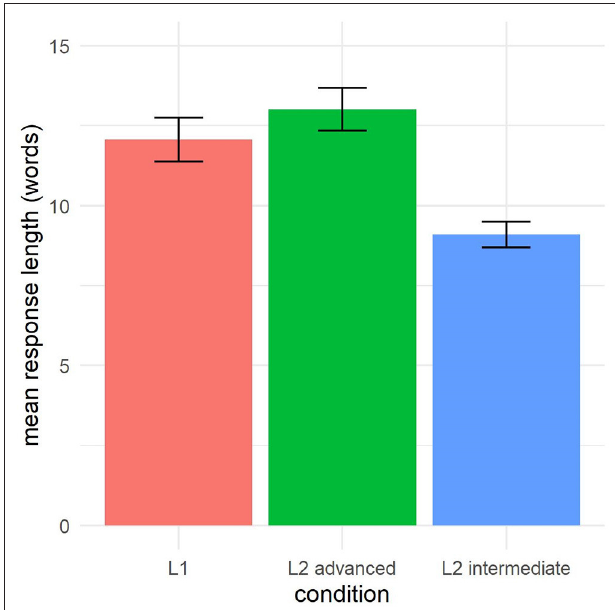
FIGURE 4 | Response length as mediated by condition (error bars: standard